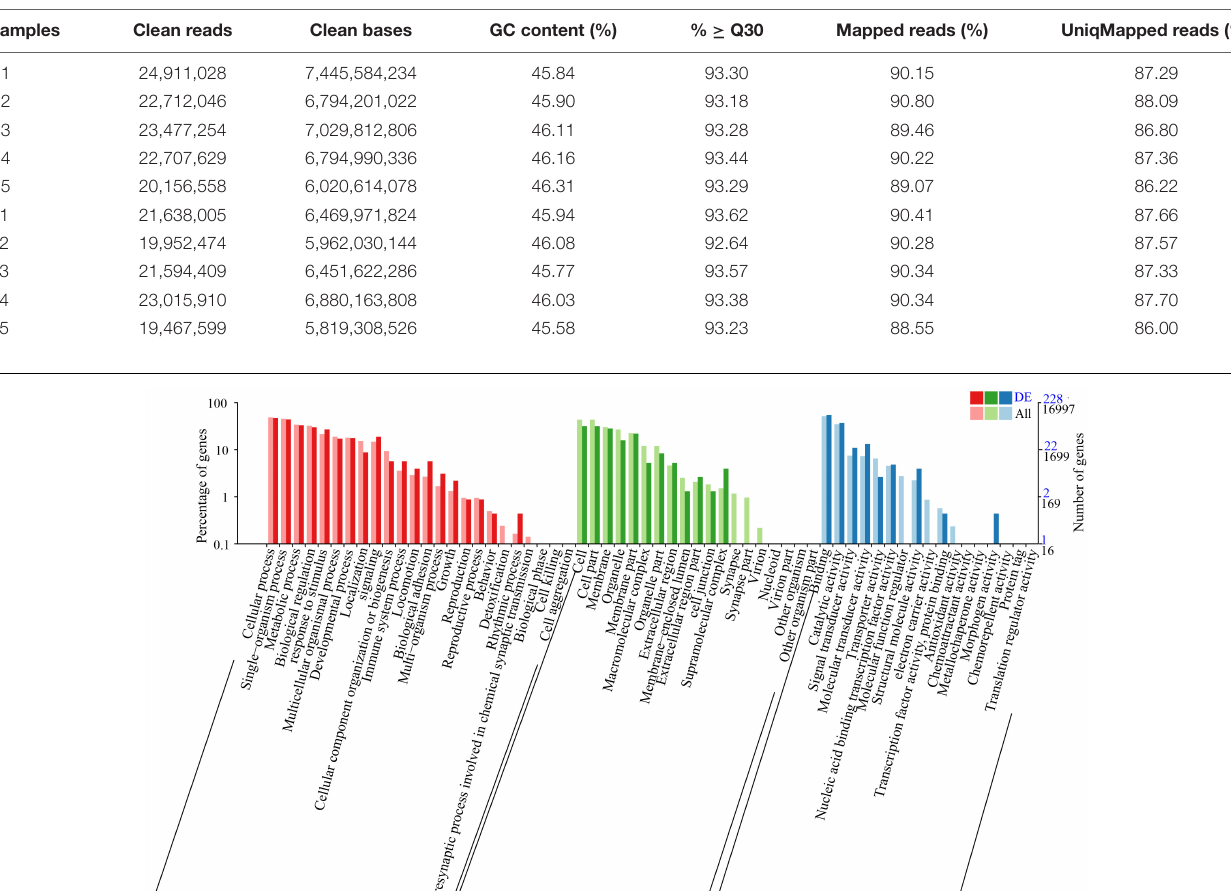
TABLE 2 | Statistics of the sequencing data and sample sequence alignment with the selected reference genomes. Samples